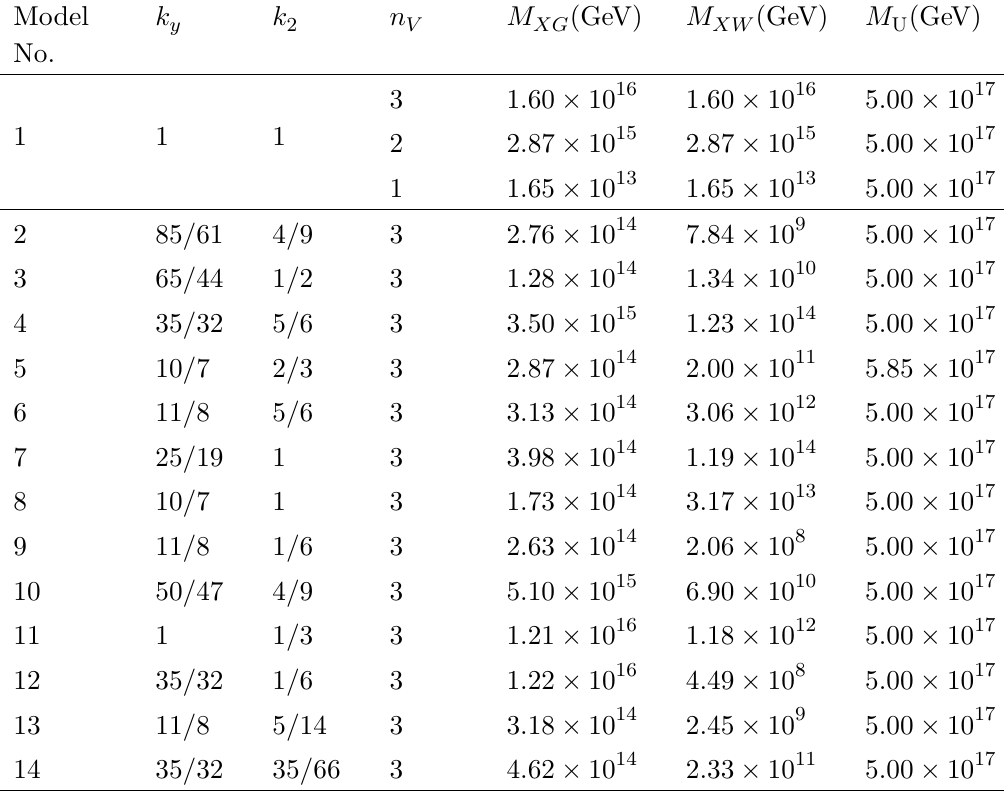
Table 3 . String-scale gauge coupling relations achieved with XG + XW , from adjoint representation of SU(4) and SU(2) .